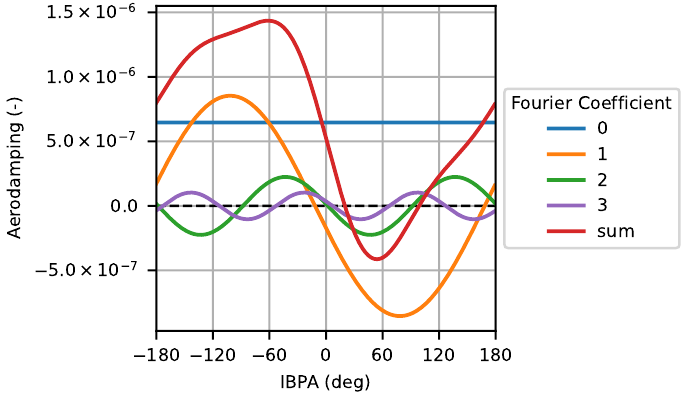
Figure 14. Aerodamping Fourier harmonics against IBPA— k = 0.2, x / c =